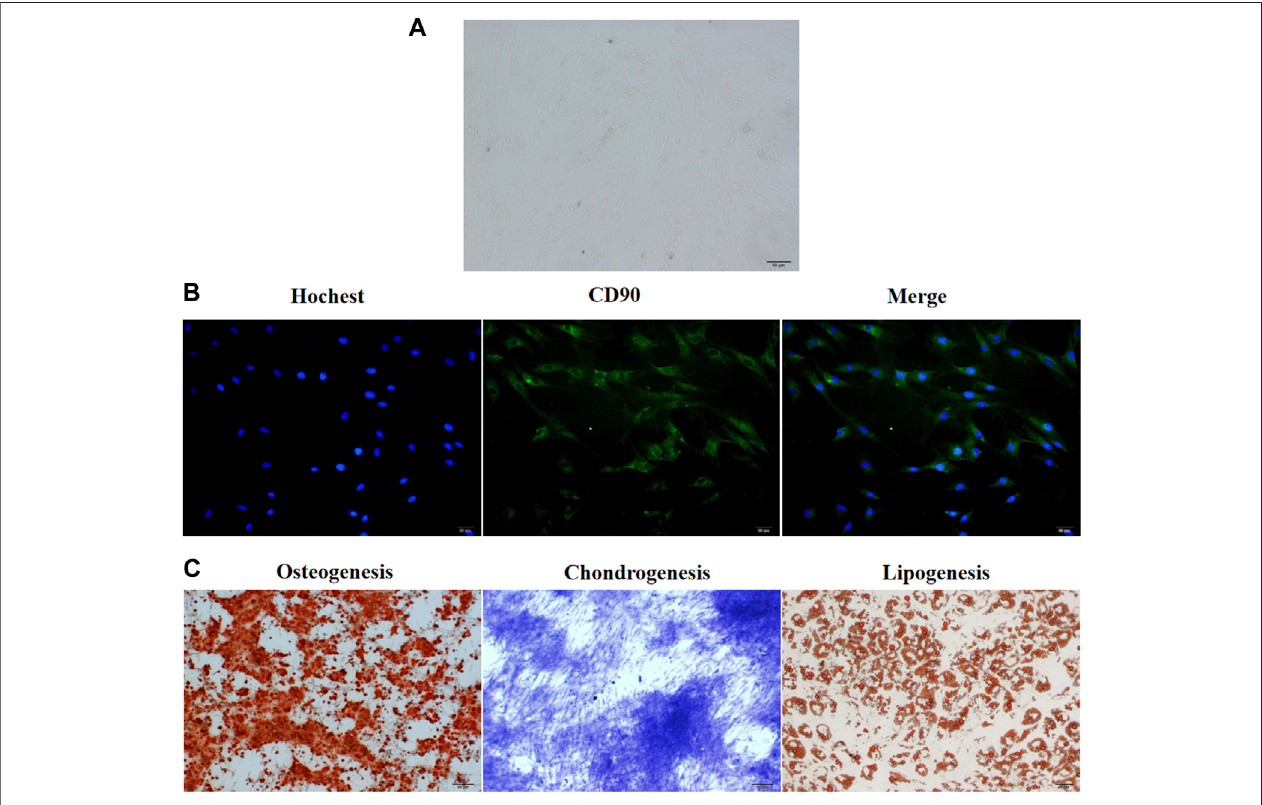
FIGURE 1 | The culture and in vitro differentiation of ADSCs isolated from the groin of male New Zealand rabbits. (A) ADSCs isolated from rabbits in New Zealand werecultured invitro for3 daysandthecellularmorphologywascapturedbyanopticalmicroscope.Therepresentativepictureweredisplayed. (B) Immuno fl uorescence assay showed that CD90 was expressed in more than 90% of ADSCs isolated from New Zealand rabbits. n (cid:2) 3. (C) The three-way differentiation ability of ADSCs into osteoblasts, chondrocytes, and adipocytes. Hoechst is a blue fl uorescent dye that can penetrate the membrane of living cells and stain the nucleus, n (cid:2) 3.